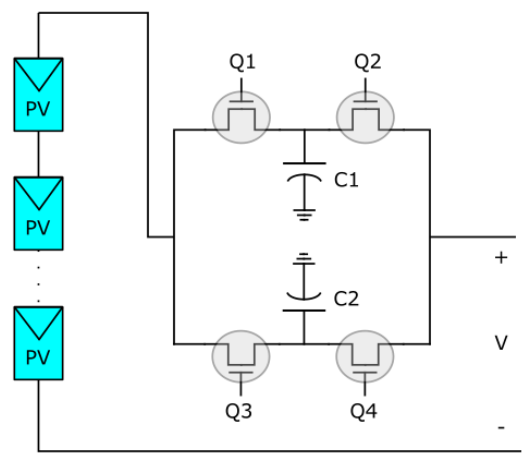
Figure 10. Electronic “semi-invasive” or “on-line” tracer installed in a junction box of a string of PV modules. Source [33] , own elaboration.